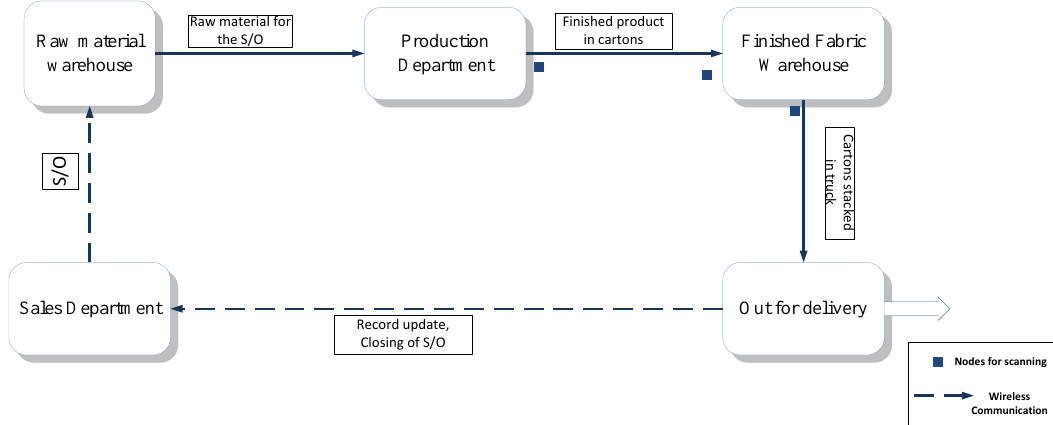
Figure 11. Block diagram of the working